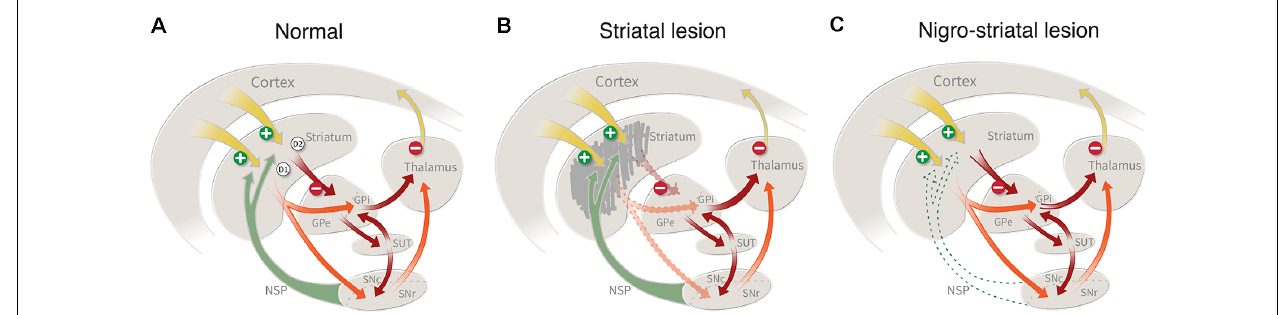
FIGURE 1 | (A) Striatal connectivity comprises two major neuronal circuits: the cortico-striato-pallido-thalamic circuit and the cortico-striato-nigro-thalamic circuit, which in turn are interlinked by an important regulatory hub, the subthalamic nucleus. The striatal projection neurons (which constitute more than 90% of all neurons in the striatum) are of two types: the D1 receptor-bearing striatonigral neurons that innervate the internal globus and the pars reticulata of the substantia nigra, and the D2 receptor-bearing striatopallidal neurons which innervate the external globus pallidus. (B) Damage to the striatal projection neurons, caused by an intrastriatal injection of ibotenic acid (IBO) or quinolinic acid (QUIN), will disrupt these two circuits and result in a disinhibition of the downstream targets, the pallidum and the substantia nigra, pars reticulata. This lesion mimics the striatal damage seen in patients with Huntington’s disease. (C) Lesion of the nigrostriatal dopamine (DA) pathway, induced by the injection of 6-hydroxydopamine (6-OHDA) or MPTP, removes an important regulatory control, resulting in motor impairments similar to those seen on patients with Parkinson’s